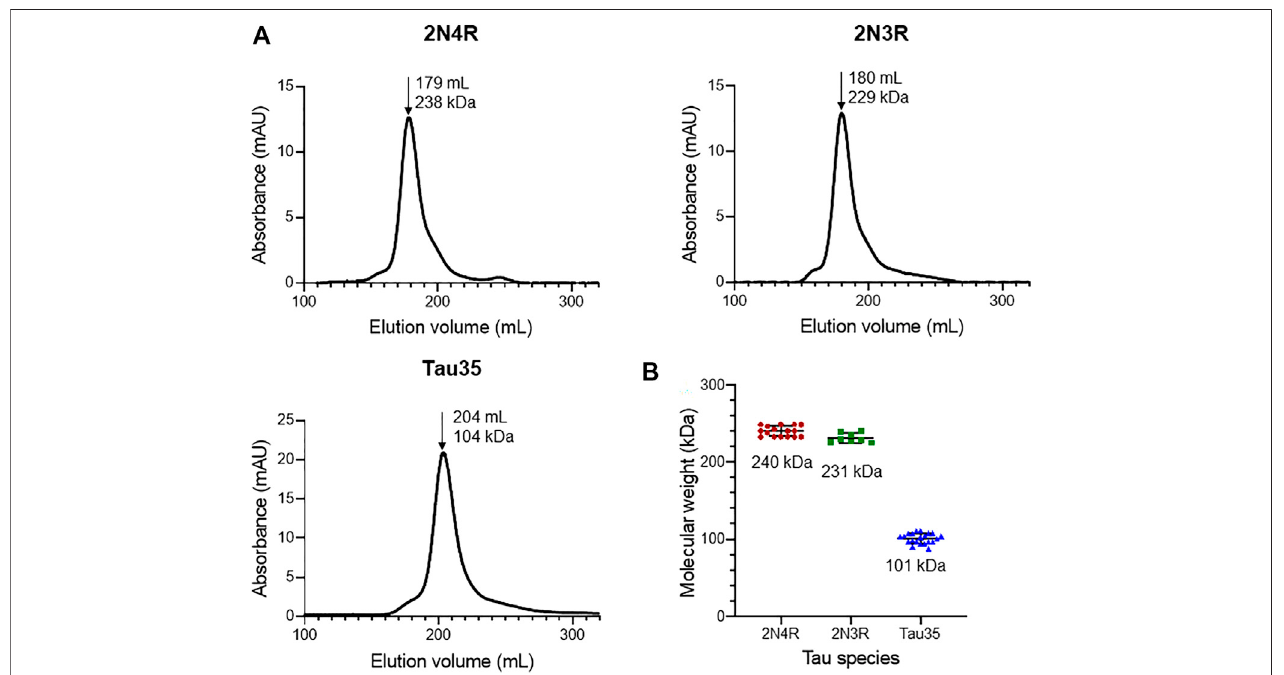
FIGURE1| Size-exclusionchromatographyofrecombinanttauspecies.Gel fi ltration(Superdex20010/300 GLcolumn)ofrecombinant2N4Rtau,2N3Rtau,and Tau35. (A) Representative elution pro fi les showing apparent molecular weights calculated from the elution volumes (arrows) of each tau species in comparison to a standard calibration curve. (B) Scatter plots showing the range of apparent molecular weights determined for each tau species. Bars indicate mean ± SD, n ≥